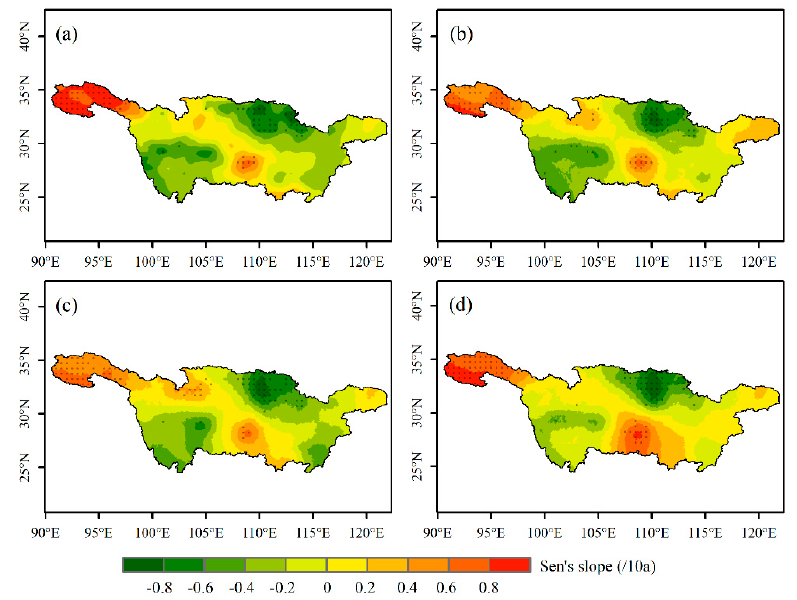
Figure 5. The trend of scPDSI in different seasons in the YRB for the period 1980–2019; shaded area indicates the significance level of 0.05. ( a ) Autumn, ( b ) winter, ( c ) spring, ( d ) summer.